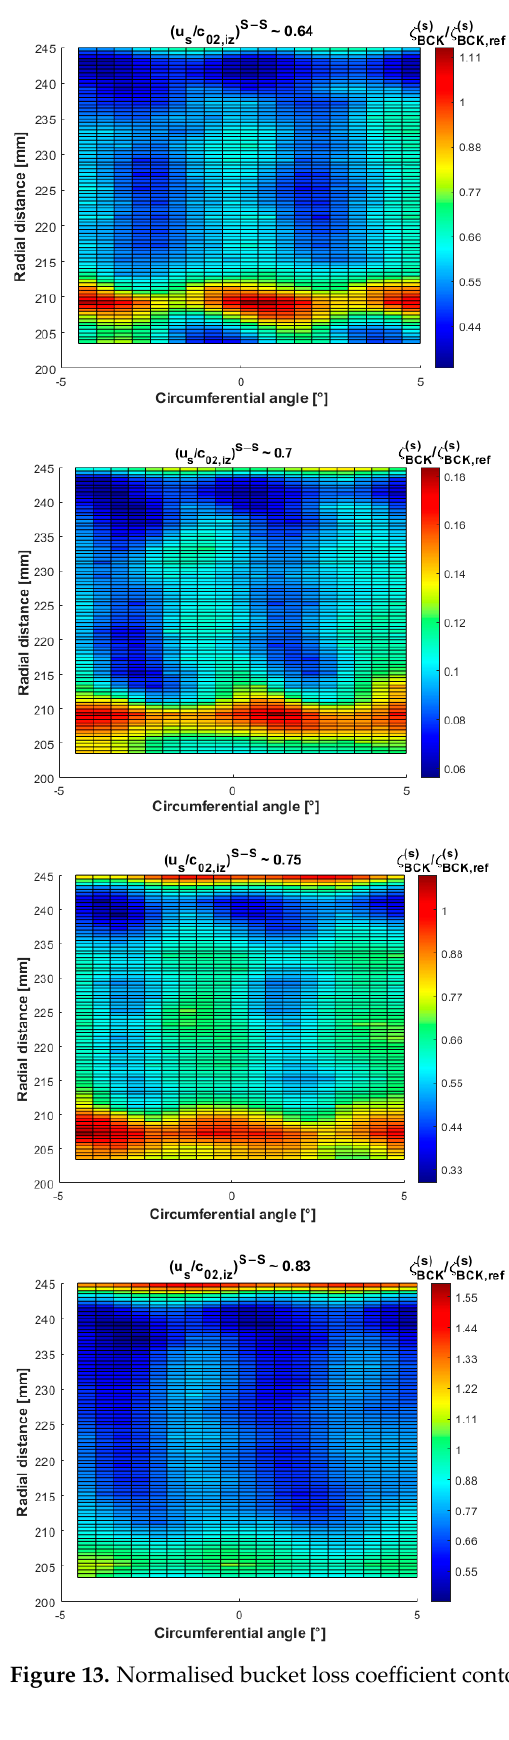
Figure 13. Normalised bucket loss coefficient contours.